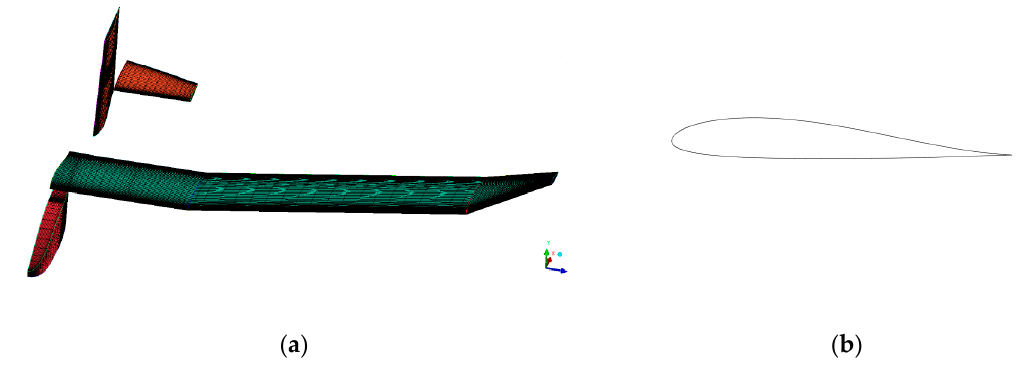
Figure 7. ( a ) Aerodynamic computing grid model. ( b ) Optimized airfoil of main wing.